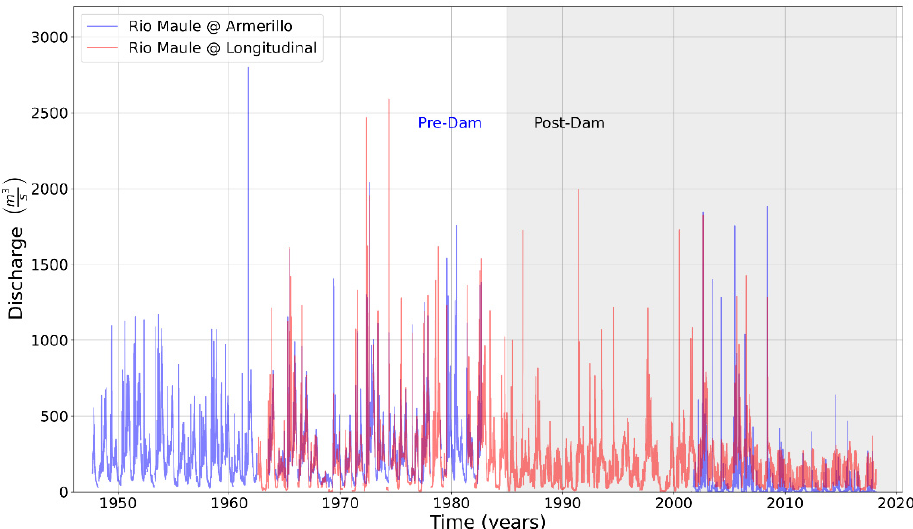
Figure 2. Daily mean flows upstream and downstream of the study area, for Maule River at Armerillo and Maule River at Longitudinal stations, respectively.